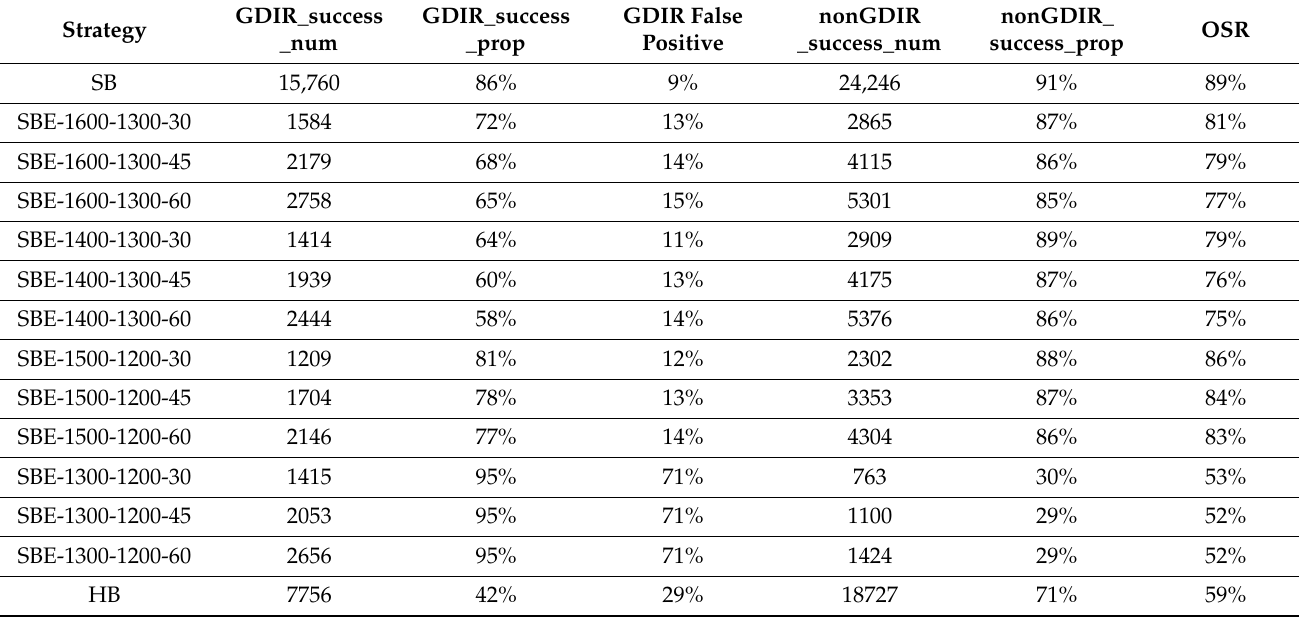
Table 2. Performance of RF models for various evaluation